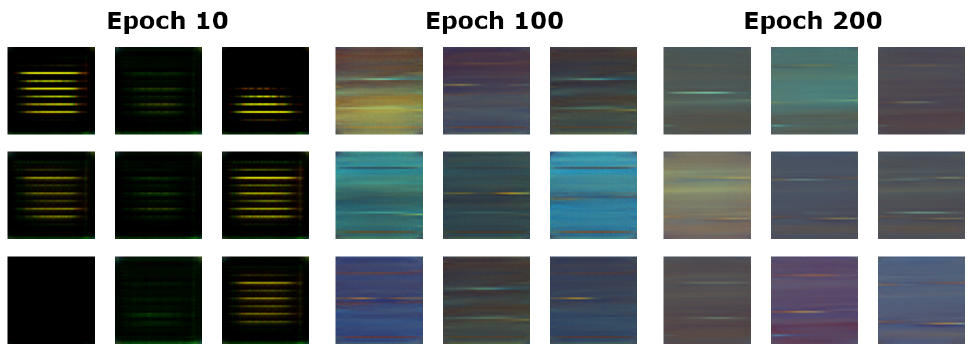
Figure 16. Evolution of the samples created in the final RGB model.